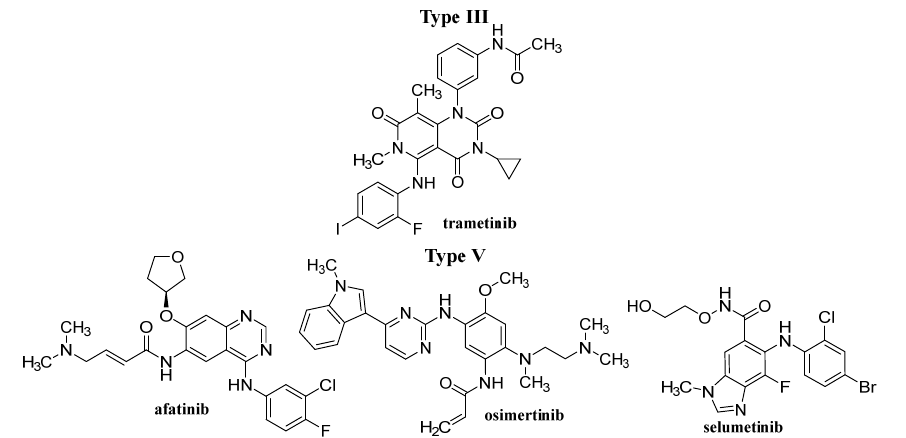
Figure 5. The structures of discussed TKIs of types III and V according to their mechanisms of action.